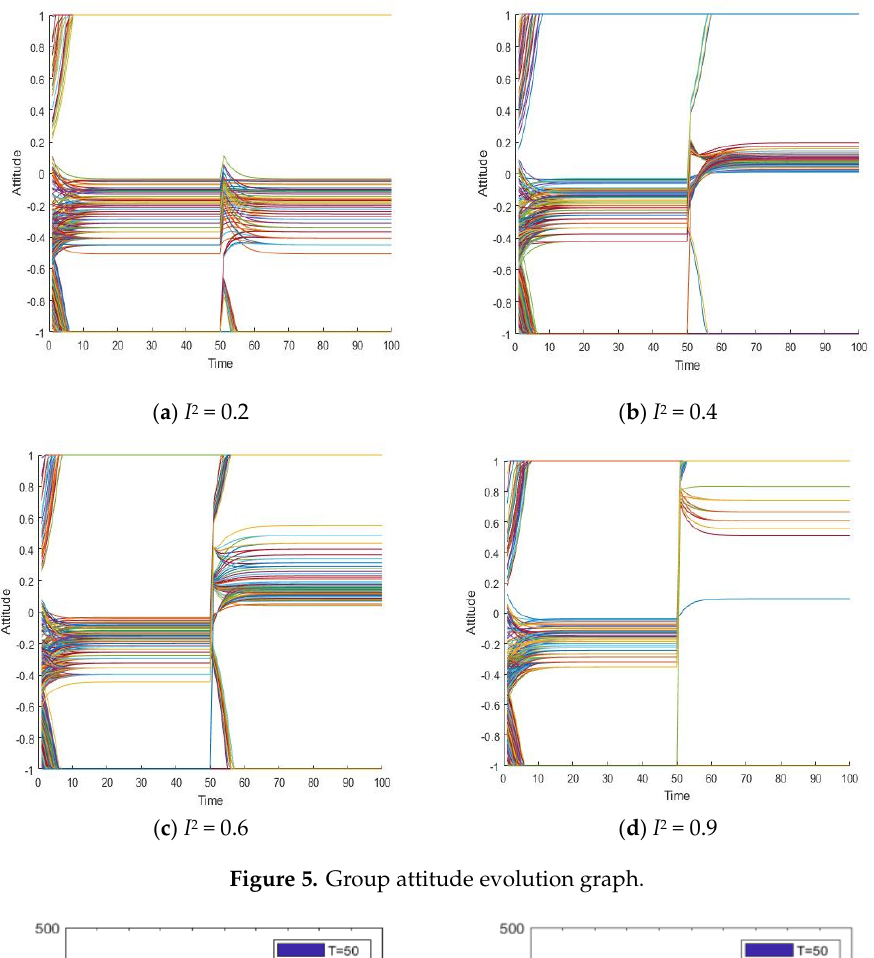
Figure 5. Group attitude evolution graph. ( a ) I 2 = 0.2; ( b ) I 2 = 0.4; ( c ) I 2 = 0.6; ( d ) I 2 = 0.9.